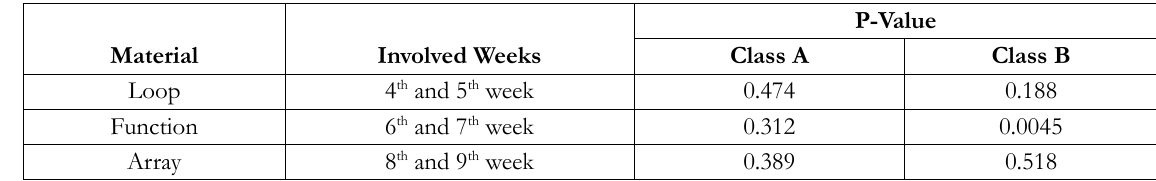
Table 2. P-value for each two-weeks in